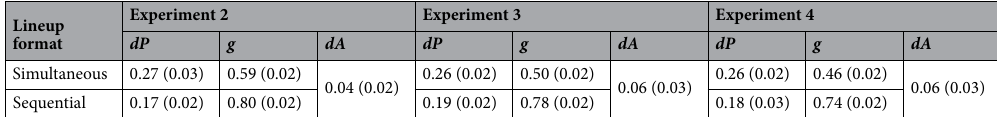
Table 2. Parameter estimates for culprit-presence detection ( dP ), guessing-based selection ( g ) and culprit- absence detection ( dA ) as a function of lineup format (Experiments 2, 3 and 4). Within the base model, parameters dP and g were each set to be equal between morphed and non-morphed lineups, separately for simultaneous and sequential lineups. Parameter dA was set to be equal among the four lineup conditions. Values in parentheses represent the standard errors. See text for